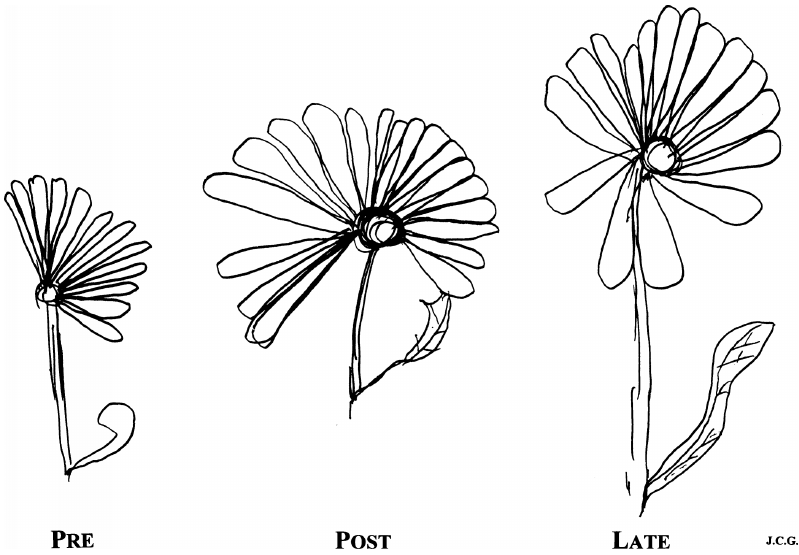
Table 1 Scores of towns evoked by J.C.G. from mental evocation of